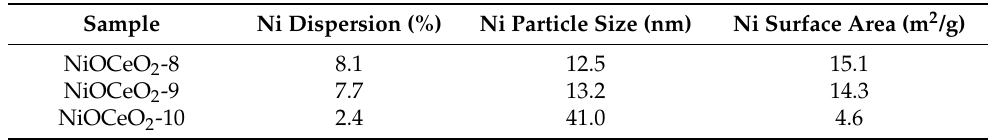
Table 2. H 2 -Chemisorption analysis of reduced NiOCeO 2